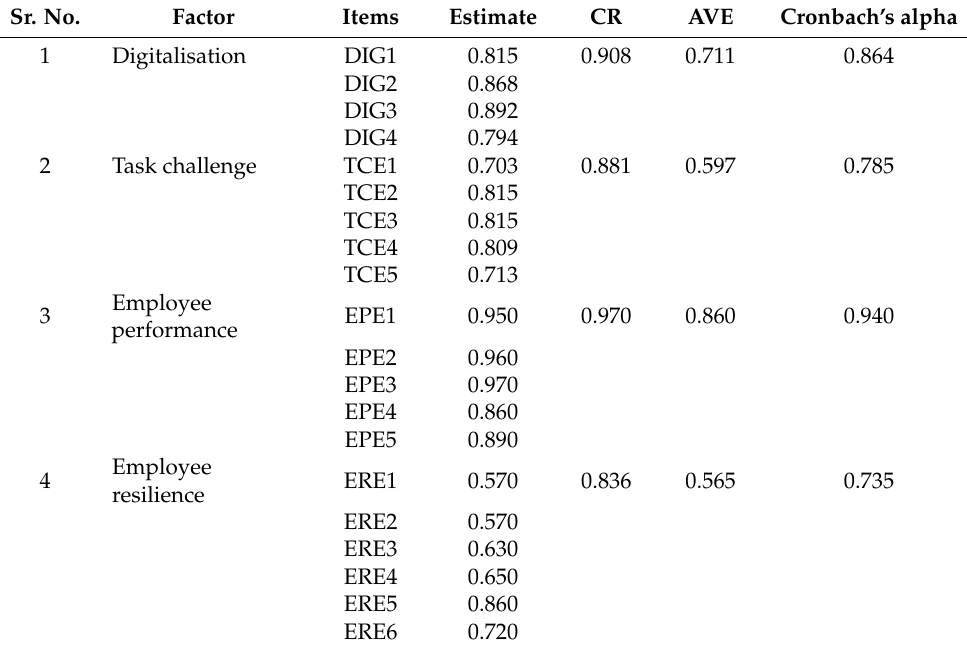
Table 1. Instrument, standardized loadings, AVE, CR and Cronbach’s alpha. Sr. No.